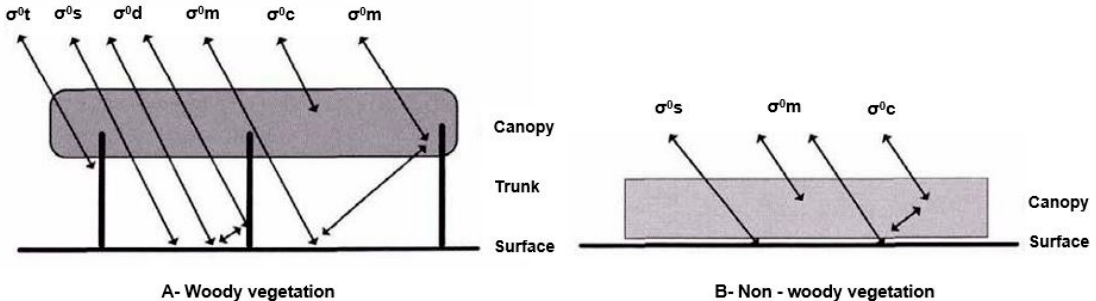
Figure 4. Sources of backscatter for vegetated wetlands in the case of ( A ) woody vegetation and ( B ) non-woody vegetation. σ 0 c = canopy backscatter, σ 0 d = soil-trunk backscatter, σ 0 m = soil-canopy non ‐ woody vegetation. (cid:2026) 0 (cid:1855) = canopy backscatter, (cid:2026) 0 (cid:1856) = soil ‐ trunk backscatter, (cid:2026) 0 (cid:1865) = soil ‐ canopy backscatter, σ 0 s = soil backscatter, and σ 0 t = trunk backscatter (modified from backscatter, (cid:2026) 0 (cid:1871) = soil backscatter, and (cid:2026) 0 (cid:1872) = trunk backscatter (modified from [46]).